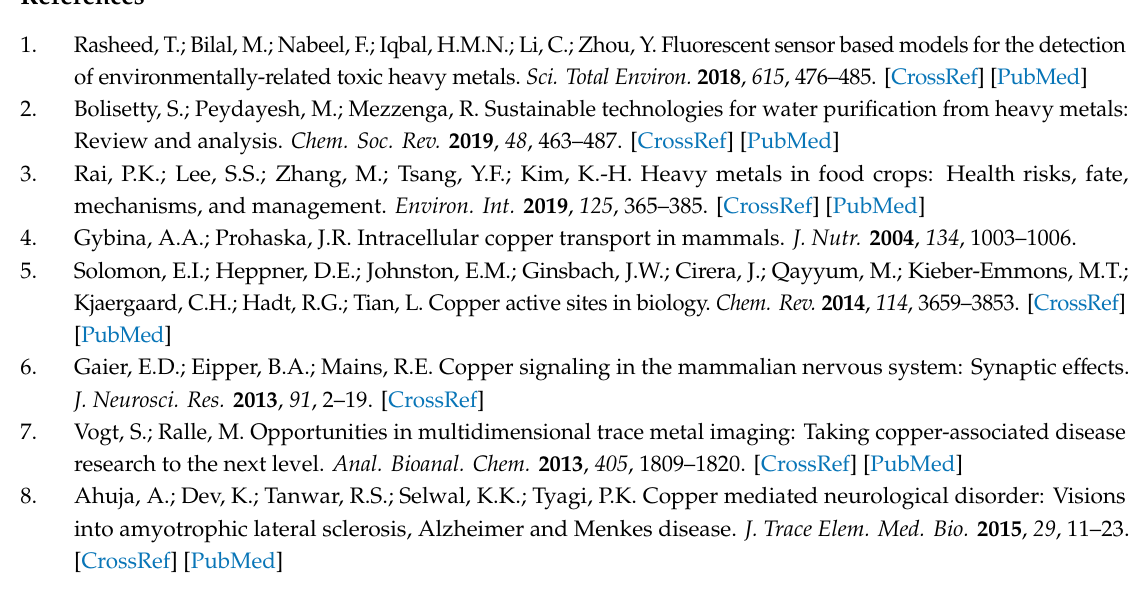
Figure S1: The batch-to-batch reproducibility for the synthesis CDs, Figure S2: Emission spectra of the CDs recorded with progressively longer excitation wavelengths; the values were taken in 10-nm increments. Inset: The normalized fluorescence emission spectra, Figure S3: ( a ) TEM image of the CDs, ( b ) histogram of the diameters of the CDs. Scale bar: 200 nm, Figure S4: ( a ) Normalized fluorescence intensity of the CDs at di ff erent pH levels, ( b ) normalized fluorescence intensity of the CDs at di ff erent concentrations of NaCl; ( c ) normalized fluorescence intensity of the CDs for di ff erent amounts of time during which they were irradiated by a UV lamp; ( d ) photostability of the CDs as a function of storage time (Excitation wavelength at 355 nm), Figure S5. Fluorescence responses of the CDs upon the addition of di ff erent concentrations of Cu 2 + (0, 0.5, 1.0, 3.0, 5.0, 7.0, 10, 30, 50, 70, 100, 300, and 500 µ M). The inset shows the linear correlation between ( F 0 − F ) / F 0 and the concentration of Cu 2 + , Table S1: Optimization of the synthetic parameters of CDs for Cu 2 + detection, Table S2: Comparison of linear range and LODs for Cu 2 + detection of di ff erent carbon dots-based